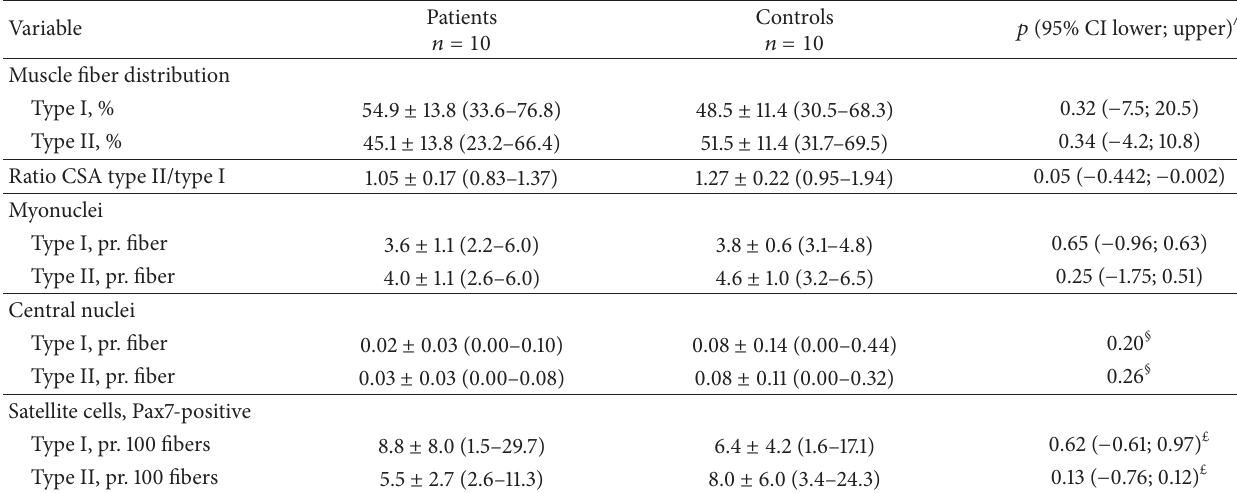
Table 3: Muscle morphology: parameters obtained from biopsy of m. vastus lateralis ∗ .